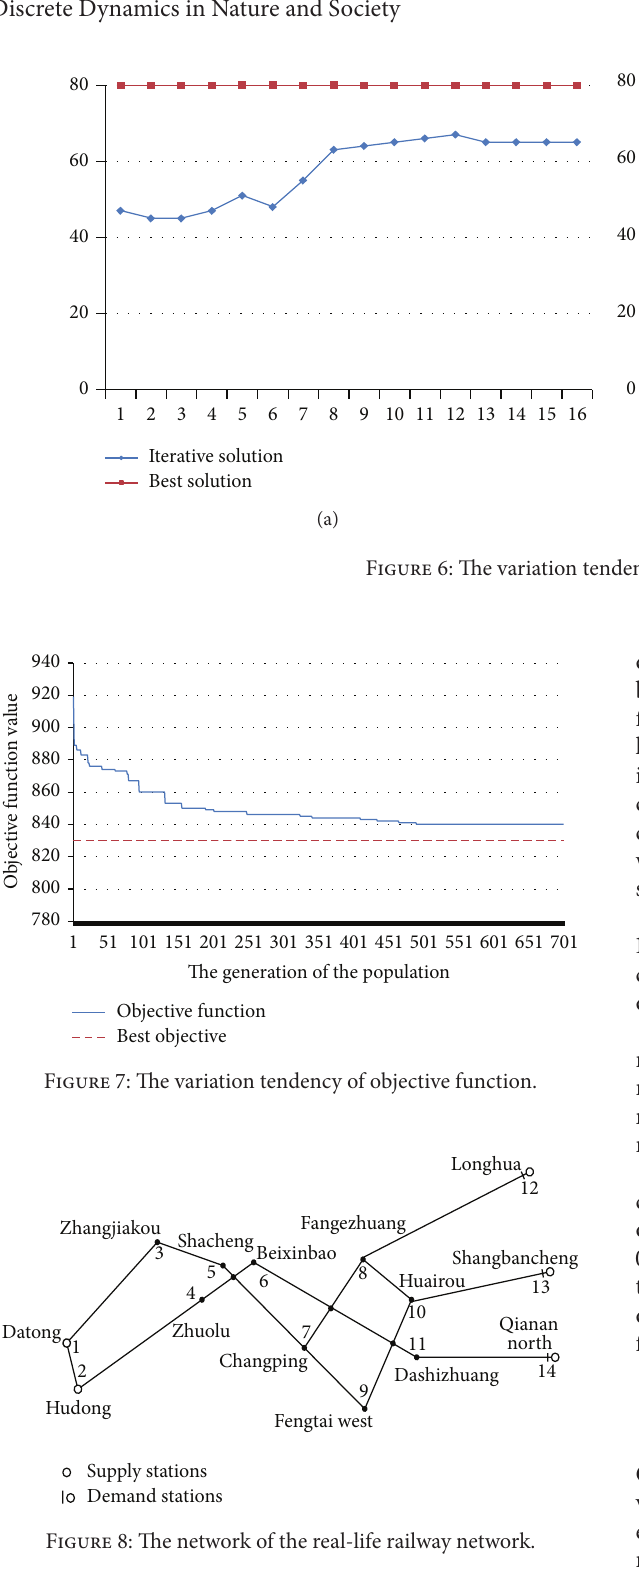
1 → 3 → 5 → 6 → 8 → 12 . In the real case, there